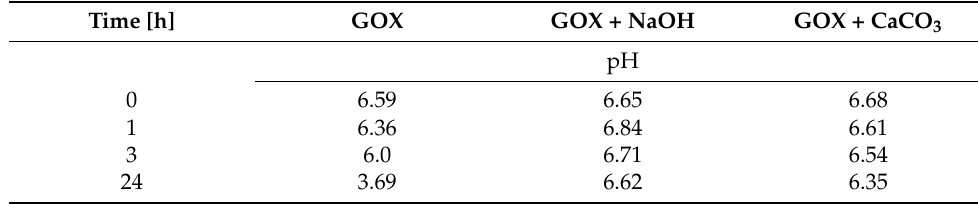
Table 1. Changes in pH during glucose oxidation catalyzed by native glucose oxidase